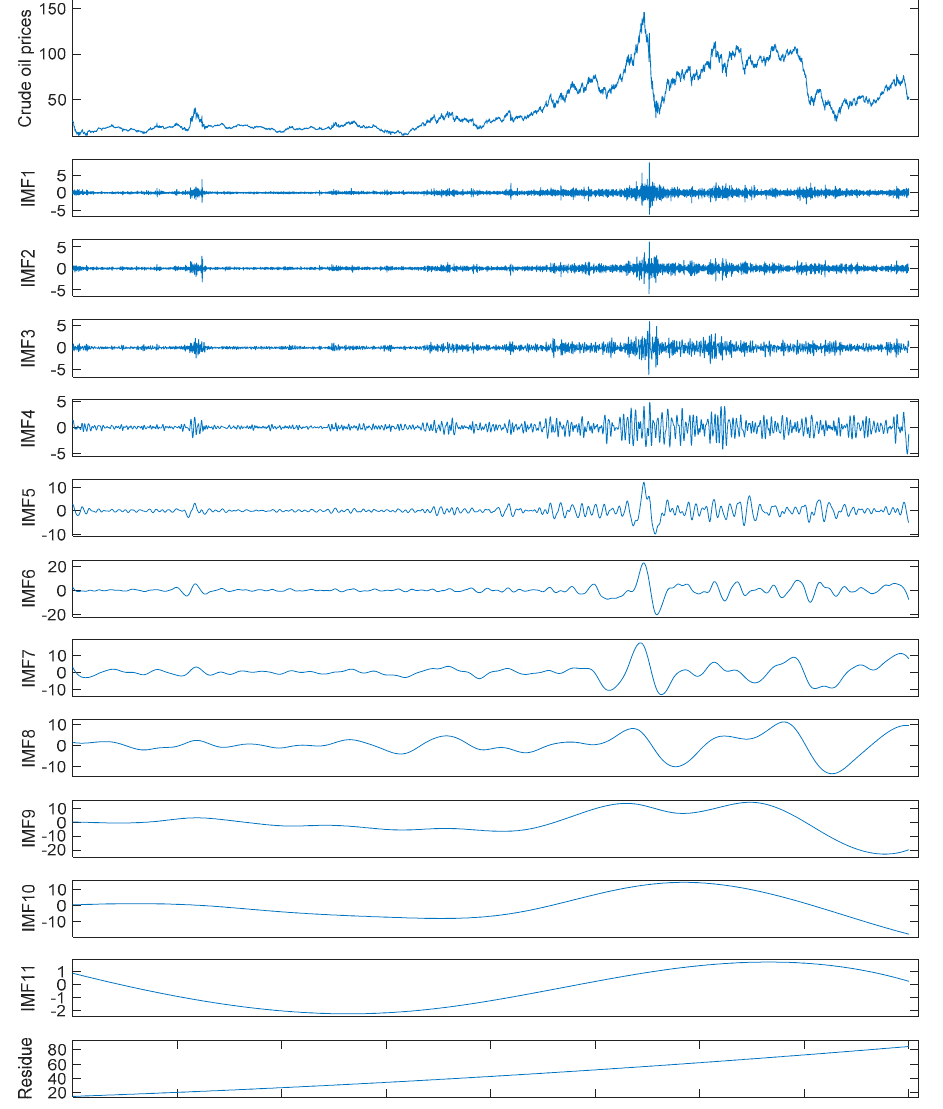
Figure 2. The original series and corresponding components decomposed by complete ensemble empirical mode decomposition (CEEMD) of WTI crude oil prices.